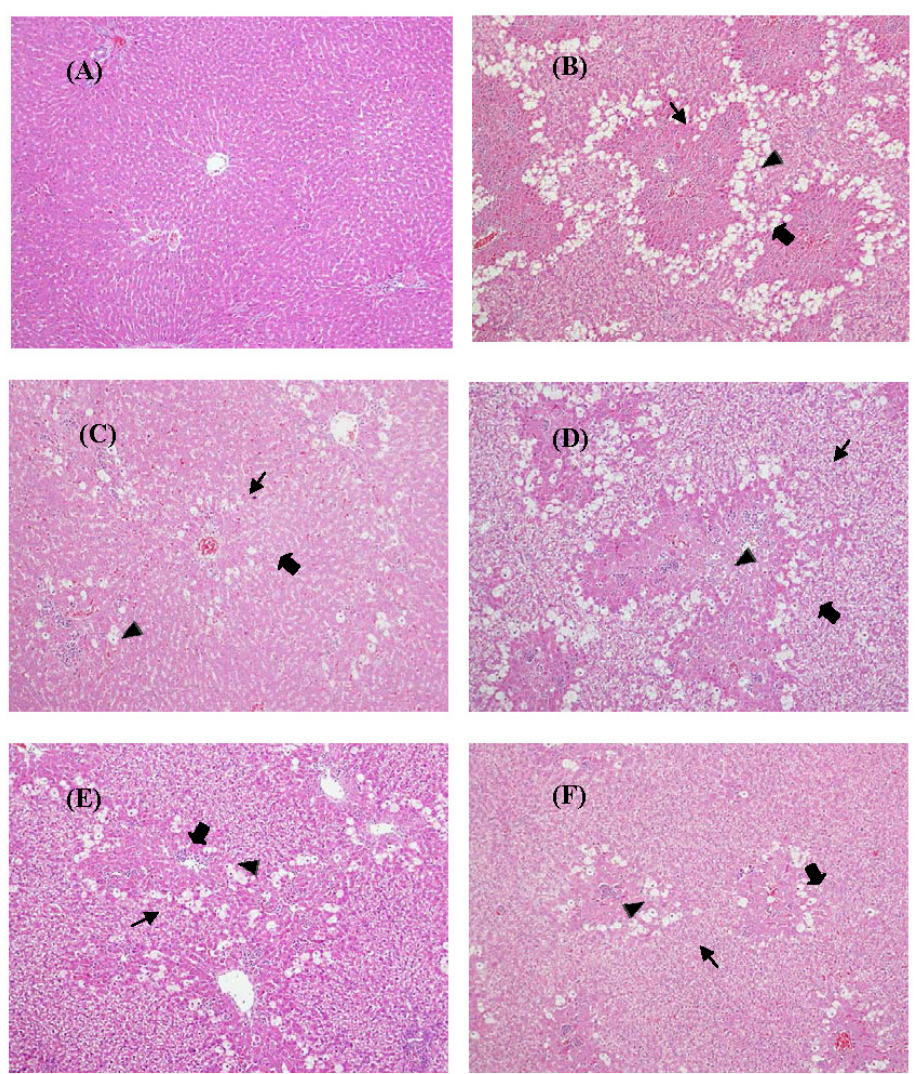
Figure 6. Effect of MOS on CCl -induced liver injury in rats. ( A ) The normal EtOH 4 architecture of the liver of the control group; ( B ) The livers of animals treated with 50% CCl (1 mL kg/bw) showed marked cell necrosis (big arrow), vacuolization (small arrow) 4 and inflammation with numerous neutrophilic infiltrations (small arrowhead). Fewer injured hepatocytes were found after treatment with sylimarin (200 mg/kg); ( C ) treatment with MOS (20, 100 and 500 mg/kg; D, E, and F groups, respectively). Hematoxylin EtOH and eosin (H and E) stain, 100×